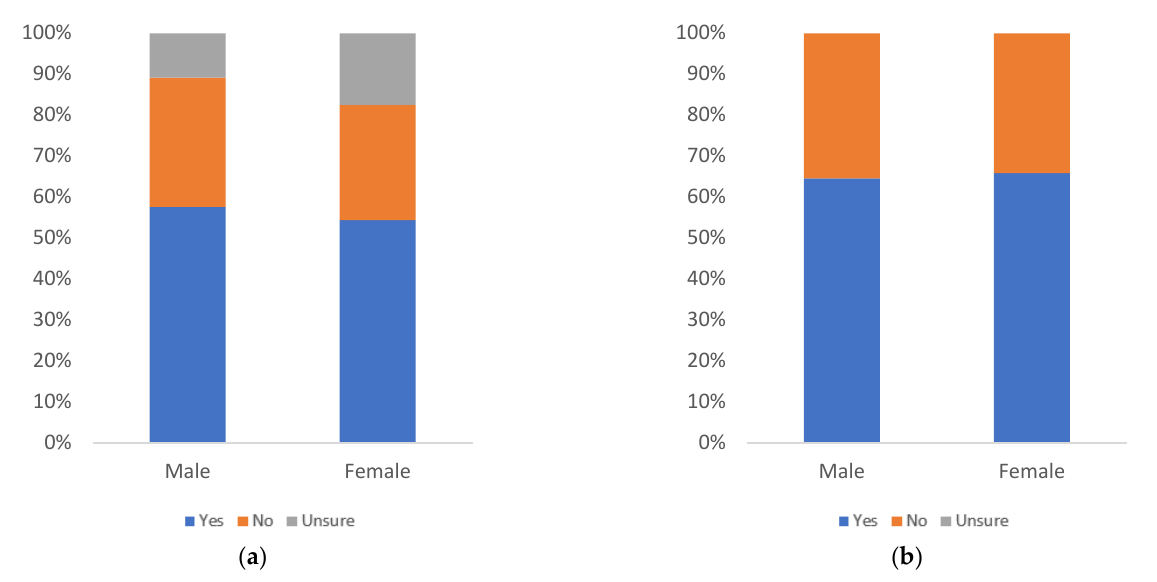
Figure 29. Label use, by gender: ( a ) with uncertain respondents (left) and ( b ) without uncertain respondents (right).